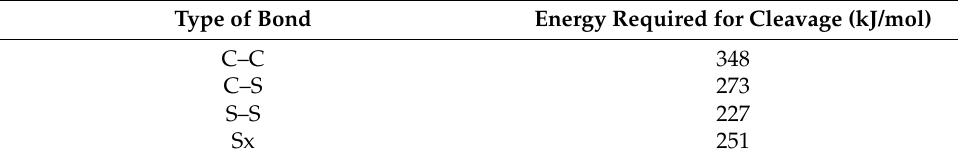
Figure 3. Temperature change inside and around the reactor. Table 1. Energy required for cleaving sulphur or carbon bonds.